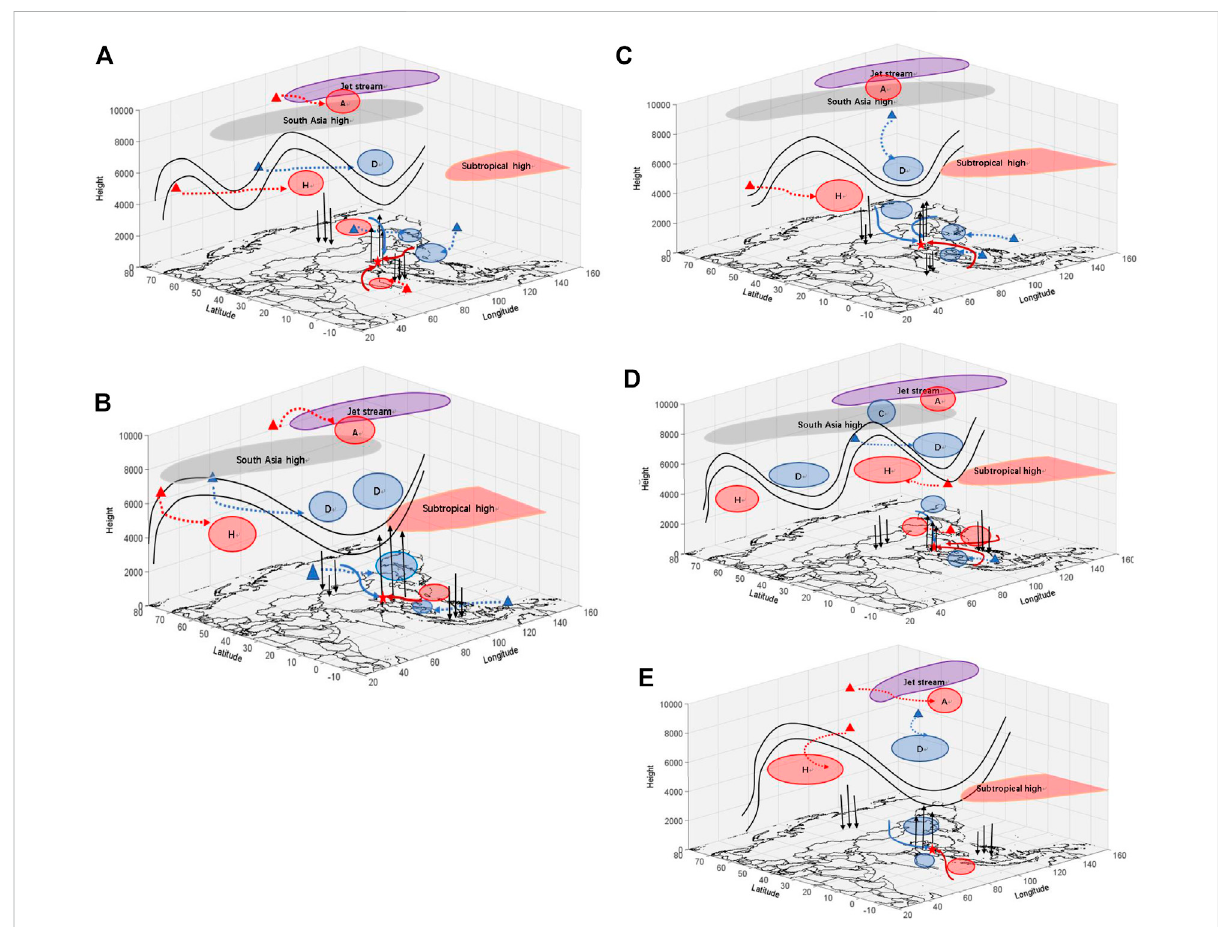
FIGURE 17 Low-frequency system con fi guration diagram of (A) Western Sichuan (B) , Basin (C) , Eastern Sichuan (D), Guizhou (E) and Yunnan. Five-pointed star represents the precipitation area, blue (red) ellipse represents cyclone or low pressure (anticyclone or high pressure), blue (red) dotted arrows represent the propagation path of low pressure or cyclone (high pressure or anticyclone), blue (red) solid arrows represent the propagation path of cold air (warm air), black arrows represent vertical air fl ow, blue (red) triangles represent low pressure or cyclone (high pressure or anticyclone) source, the black solid line represents the high-altitude